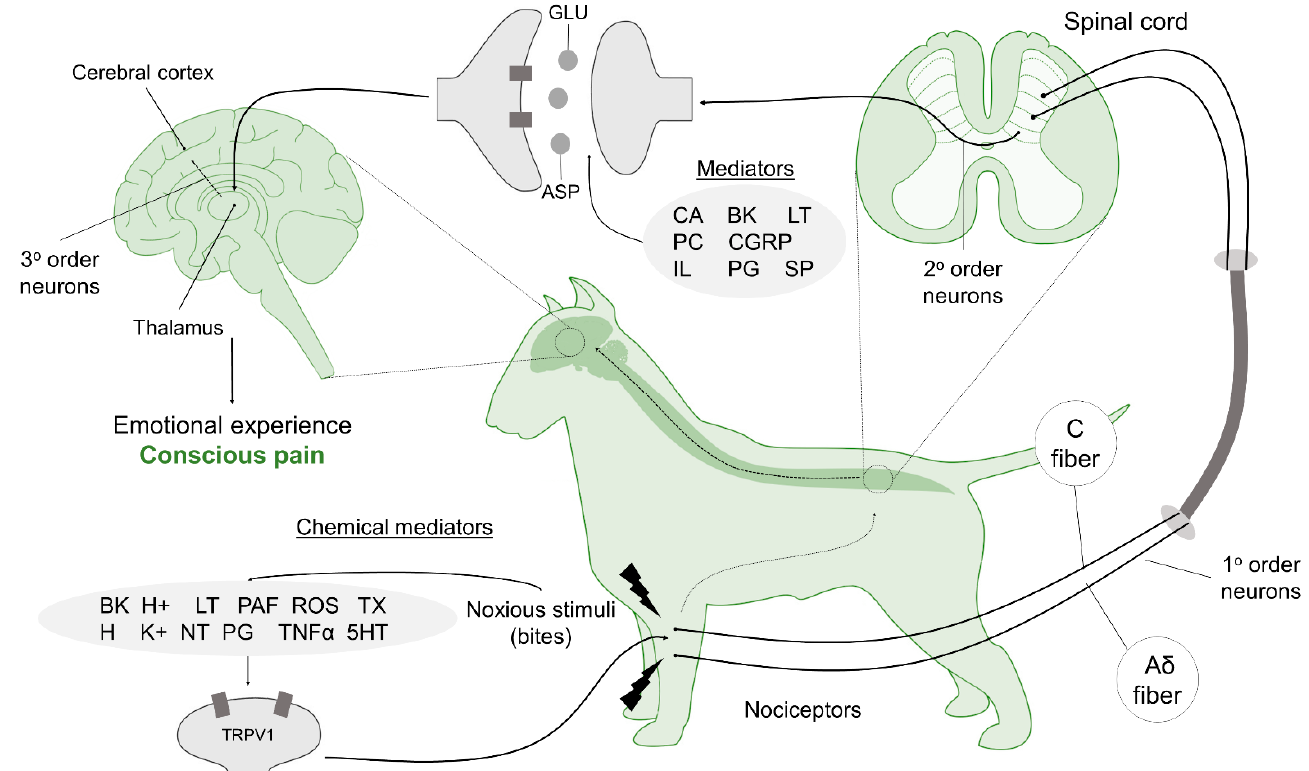
Figure 5. Route of nociceptive transmission from the peripheral nerves to the CNS, beginning with transduction of a nociceptive stimulus during a dogfight. Abbreviations: ASP: aspartate; BK: brad-